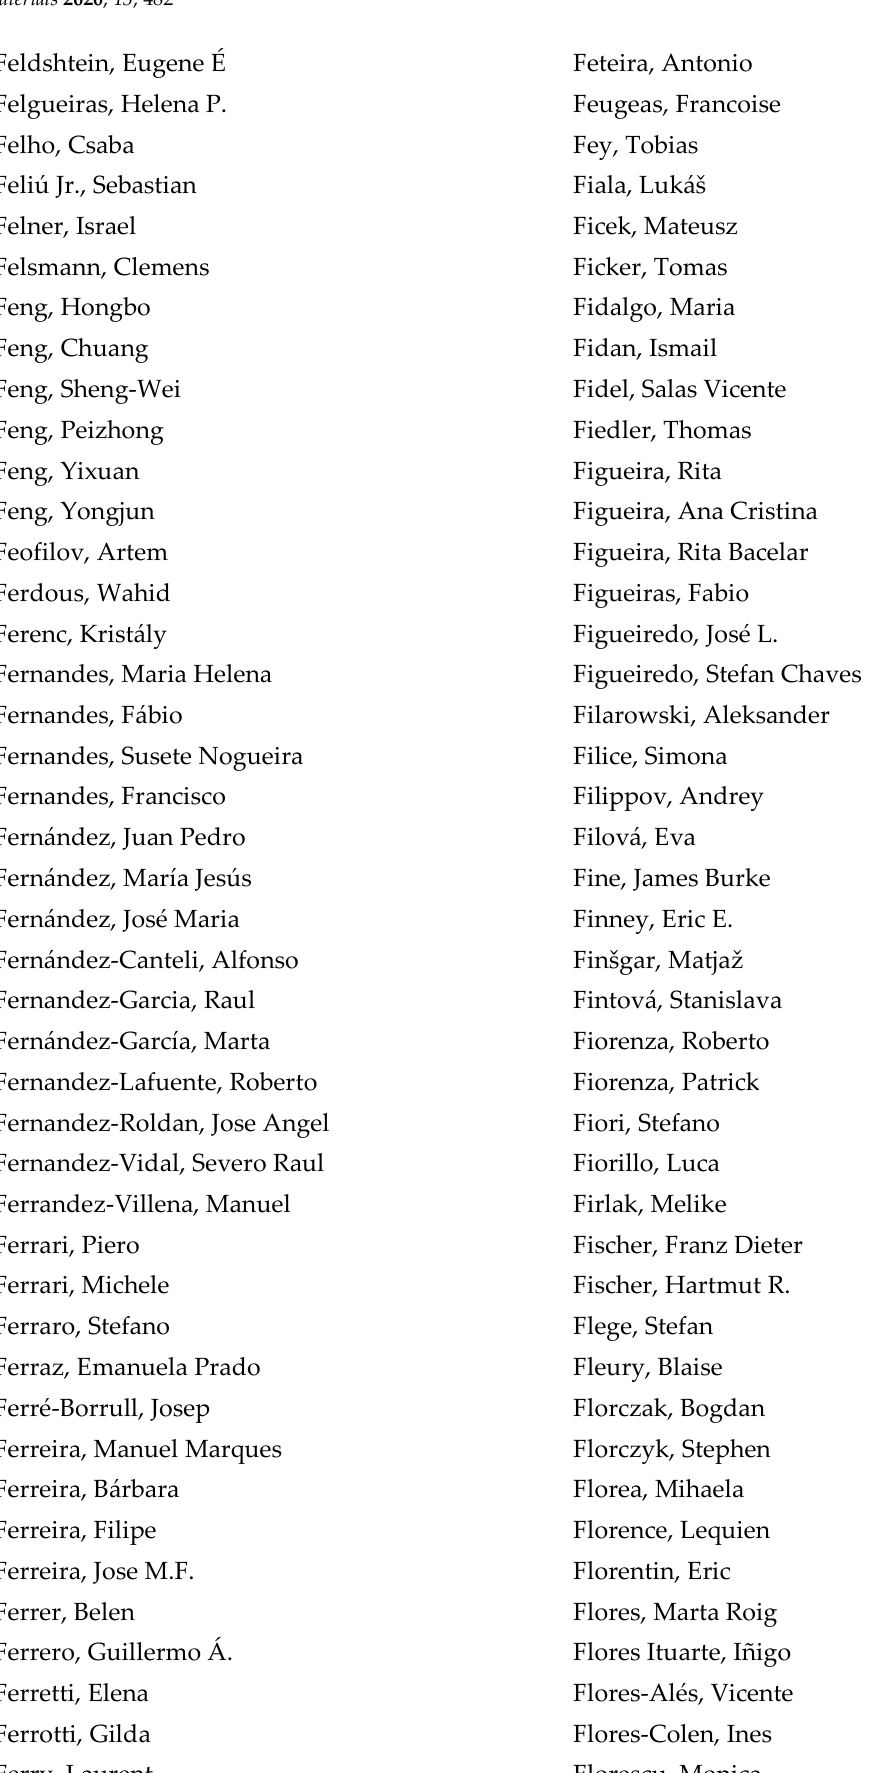
Figueira, Rita Figueira, Ana Cristina Figueira, Rita Bacelar Figueiras, Fabio Figueiredo, José L. Figueiredo, Stefan